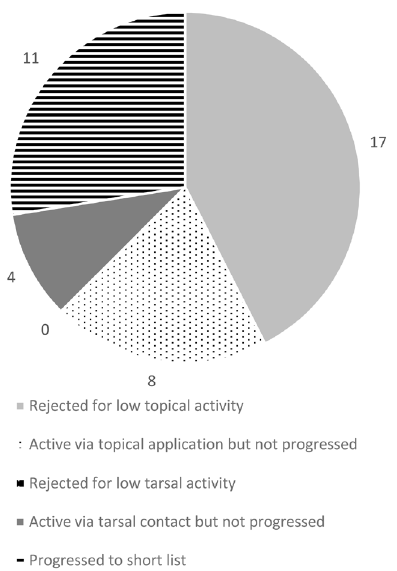
Figure 2. Fate of the 40 compounds taken through the testing cascade. In general, compounds which were active ( ≥ 80%